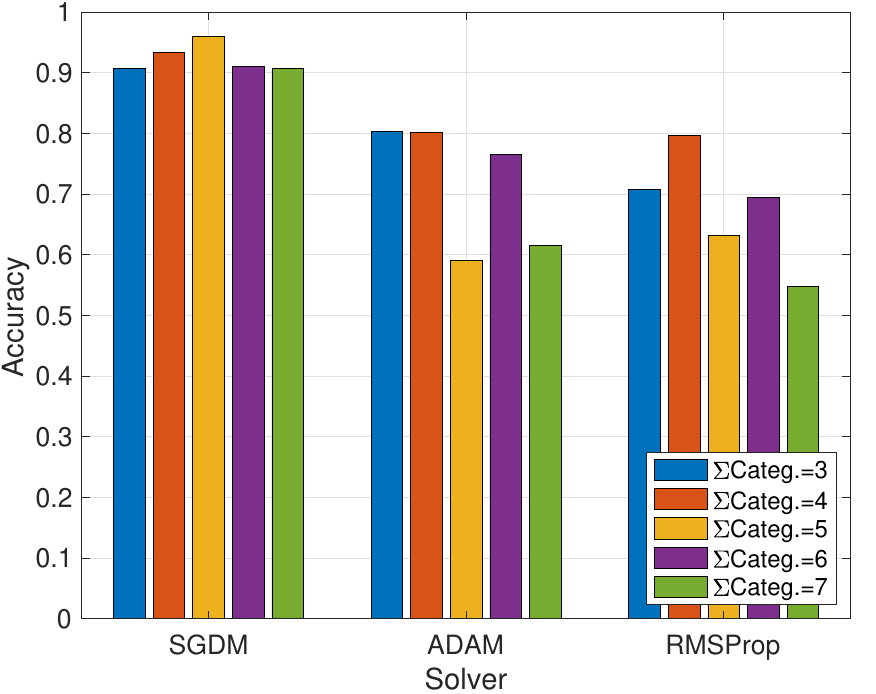
Figure 8. Classification accuracy versus solver-type for acceleration sensor. No. of hidden units = 150, sample rate = 10Hz.